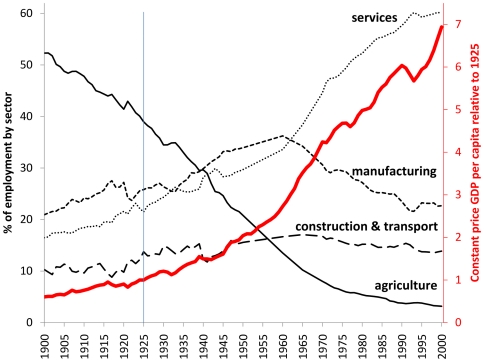
Key aspects of Sweden's developmental trajectory during the 20th century.